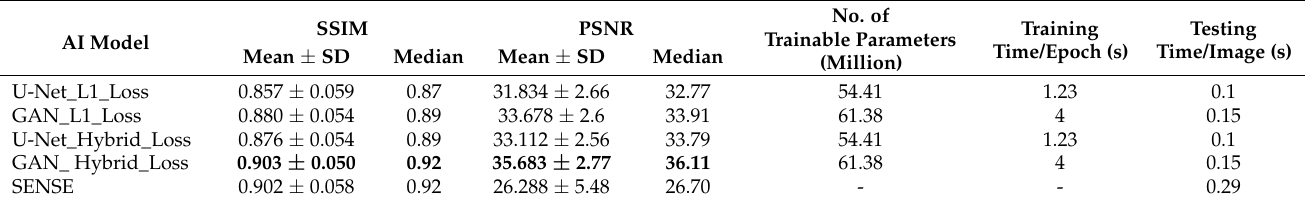
Table 2. Reconstruction performance evaluation of the proposed methodology against SENSE over the test